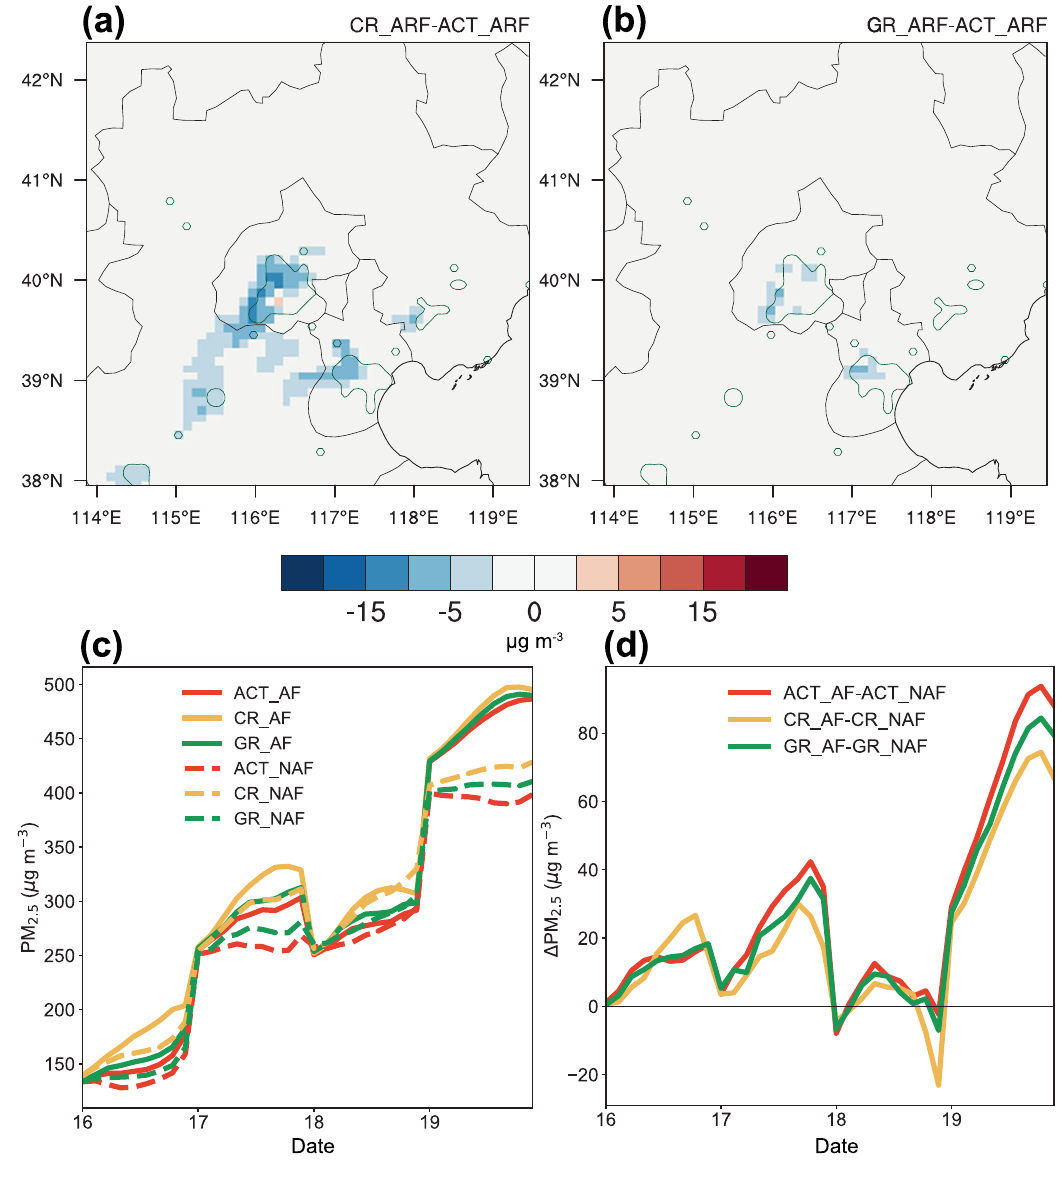
Fig. 3 Spatial and temporal differences in ARF-induced PM 2.5 concentration. Difference in daytime (9:00 – 17:00 LST) mean near-ground PM 2.5 concentration a between CR_ARF and ACT_ARF, b between GR_ARF and ACT_ARF; temporal variation of daytime c near-ground PM 2.5 concentration and d ARF-induced